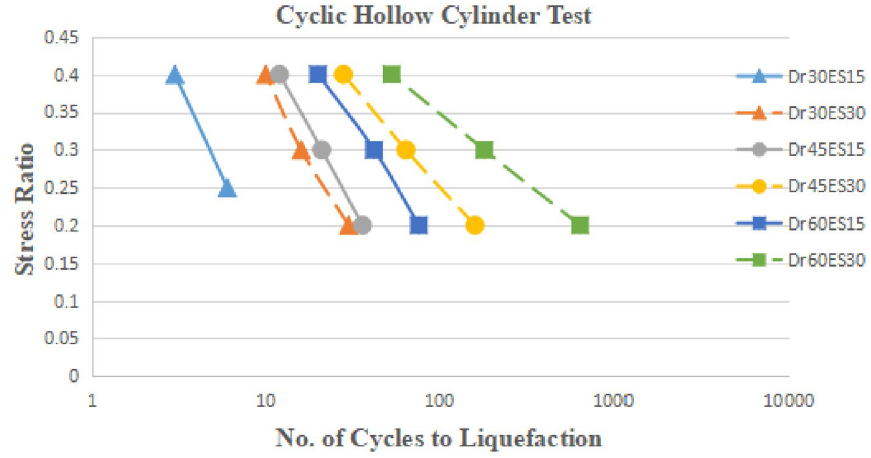
Figure 16. Stress ratio vs number of cycles to liquefaction in CHCT.